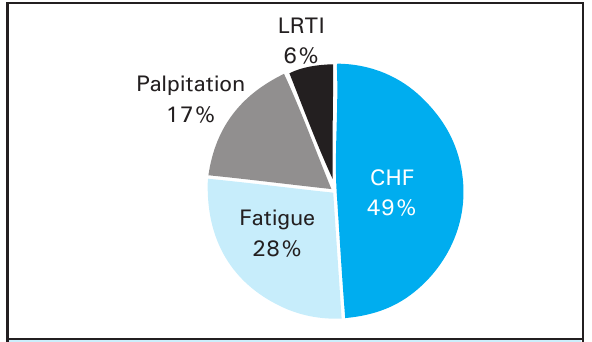
Figure 3. Common clinical